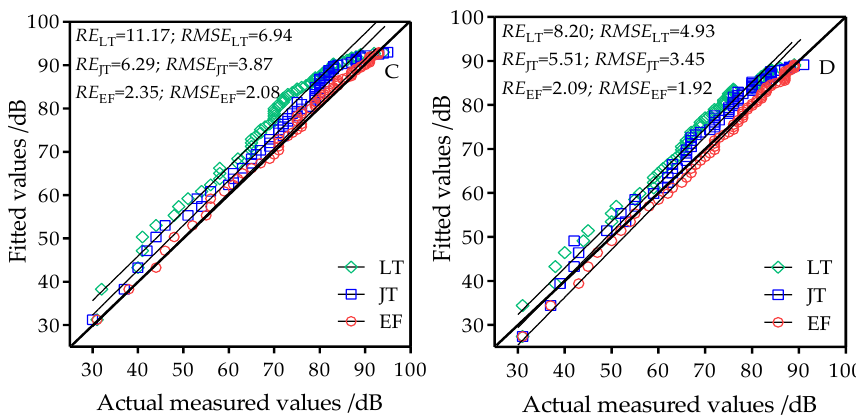
Figure 5. Comparison chart of fitted values from the two-ray model and actual measured values at antenna heights of ( A ) 0.8 m; ( B ) 1.2 m; ( C ) 1.6 m; and ( D ) 2.0 m; LT: tillering stage; JT: jointing stage; EF: grain filling stage.